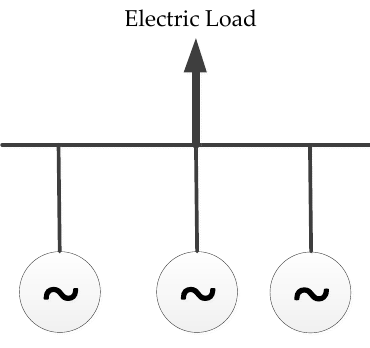
Figure 3. The first system with three units. Table 1. Comparison of results obtained for three-unit system with the first revenue model.